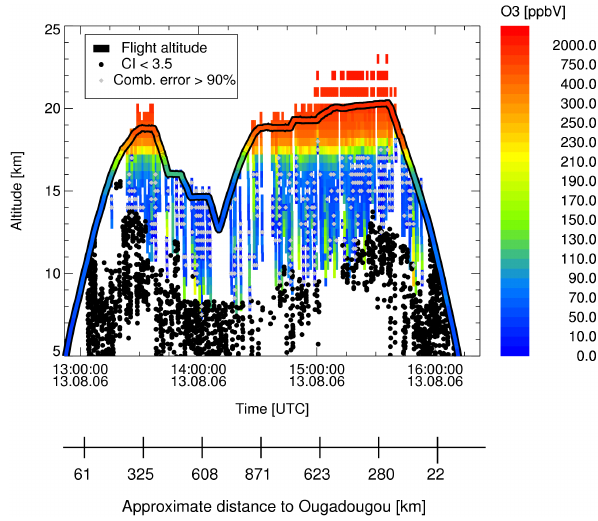
Fig. 12. CRISTA-NF and FOZAN O 3 during flight L5. The FOZAN O 3 are plotted along the flight altitude with the same color scale as the 2-D representation of CRISTA-NF O 3 . Black dots mark spectra with a CI lower than 3.5. Note nonlinear color scale.